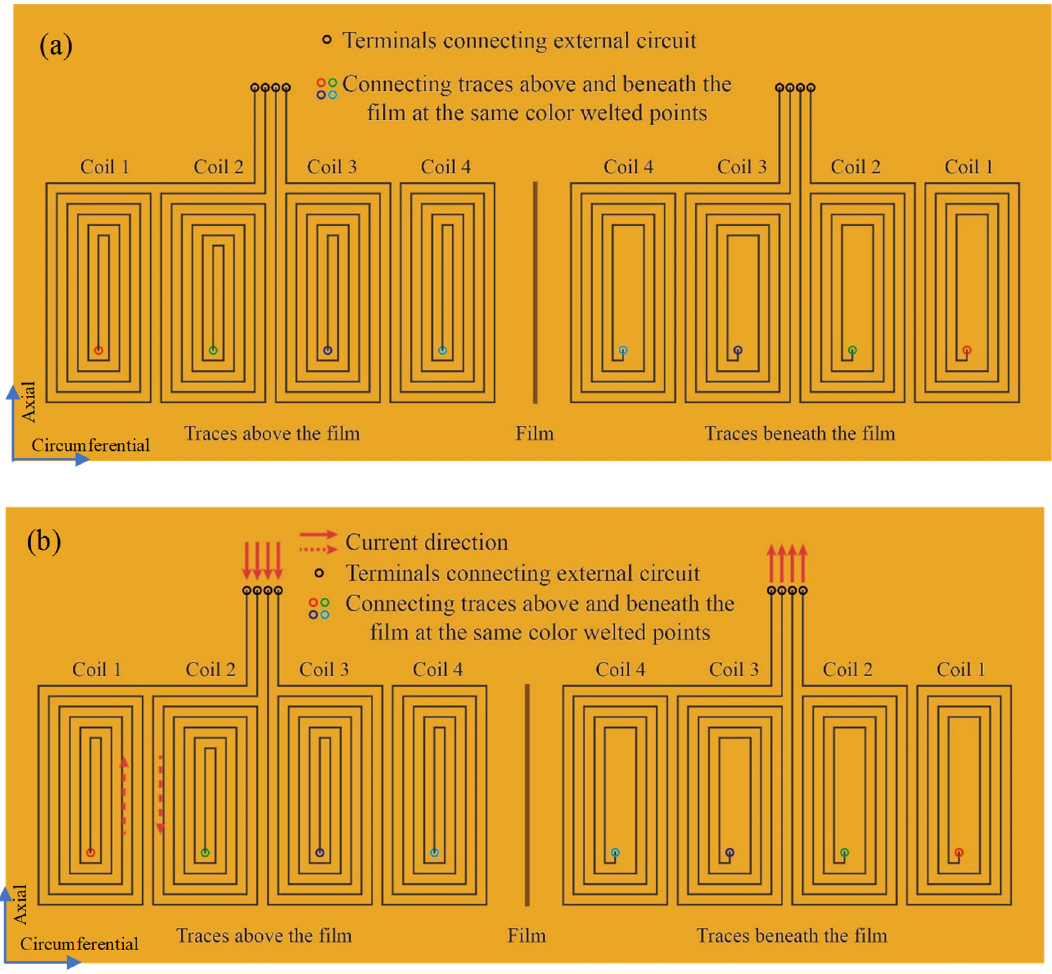
Figure 1. The configuration of the sensing film with one-dimensional coil array. ( a ) The configuration of sensing coil array; ( b ) The configuration of exciting coil.